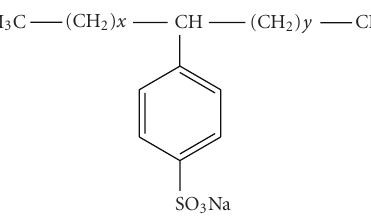
Figure 1: General chemical structure of linear alkylbenzene sulfonate (LASs), where x and y corresponds with the number of CH 2 on each side of the benzene sulphonate group (7 • x + y •